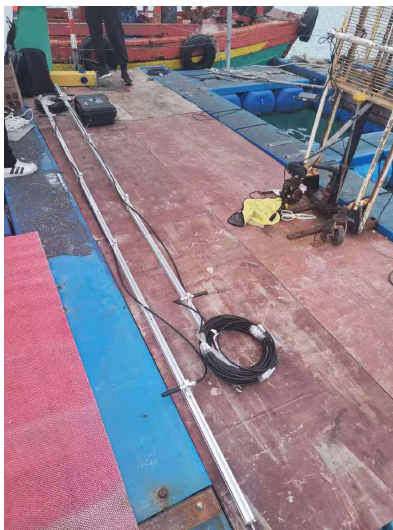
Figure 12. Acquisition station.